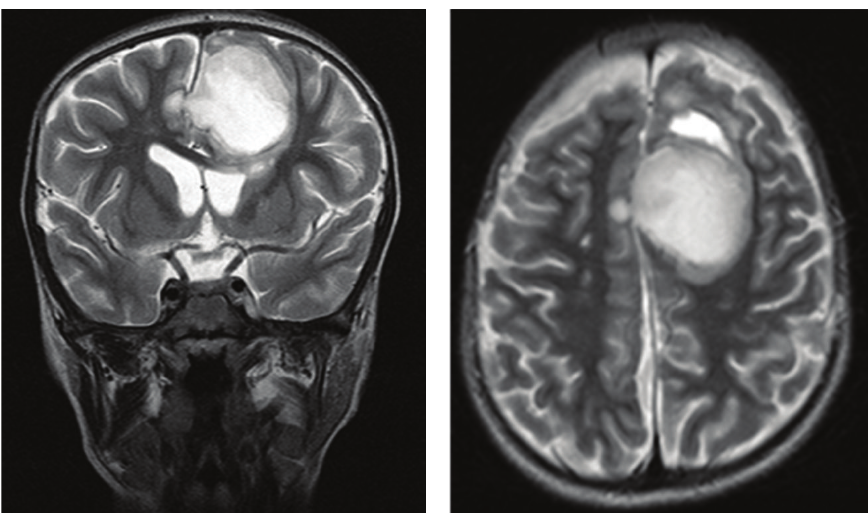
Figure 5: Brain MRI showing expansion of aspirated brain abscess to contralateral frontal lobe.